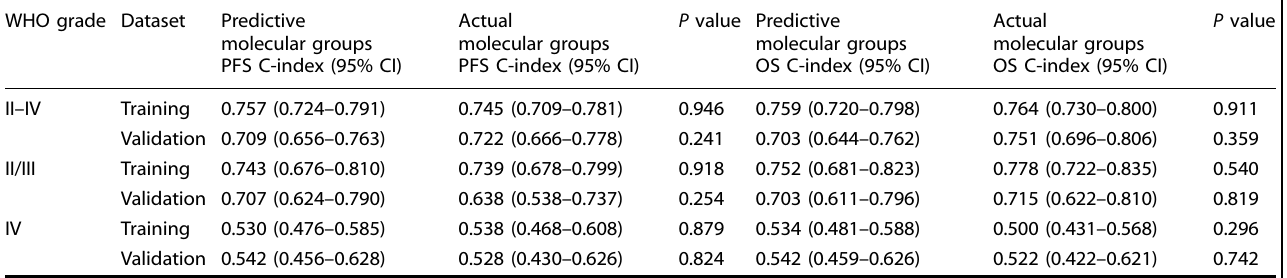
Table 2. Prognostic performance of the predictive and actual molecular groups for predicting PFS and OS.